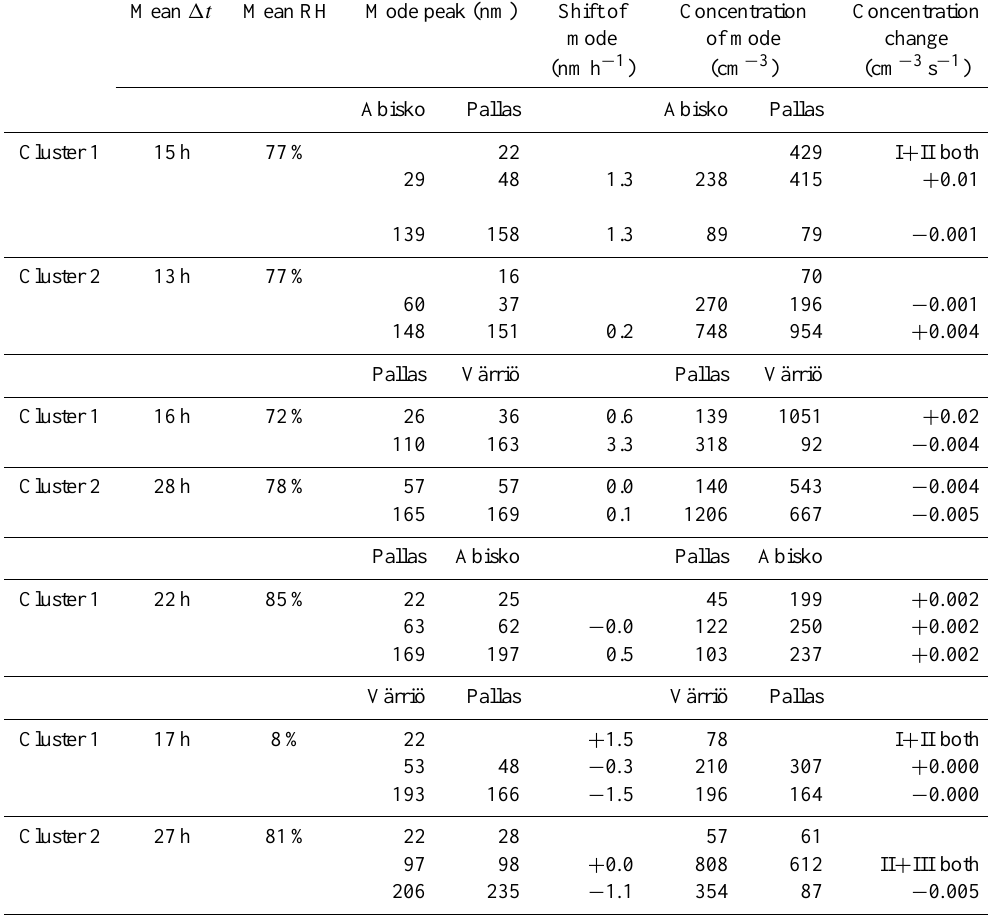
Table 4. Dynamics of particle number size distributions when air masses travel from one site to another, summer season. The initial number size distributions are clustered and a log-normal fitting in the both ends of the paths is used to find the mode peak diameters and mode concentrations. In this table, the changes in mode peak diameters and mode concentrations are